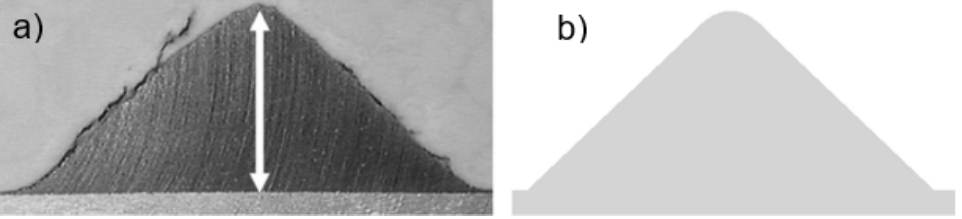
Figure 3. Deposition profile in ( a ) Kotoban et al.’s work (Adapted from Reference [25] with permission (Copyright Elsevier 2017)) and ( b ) the current study.